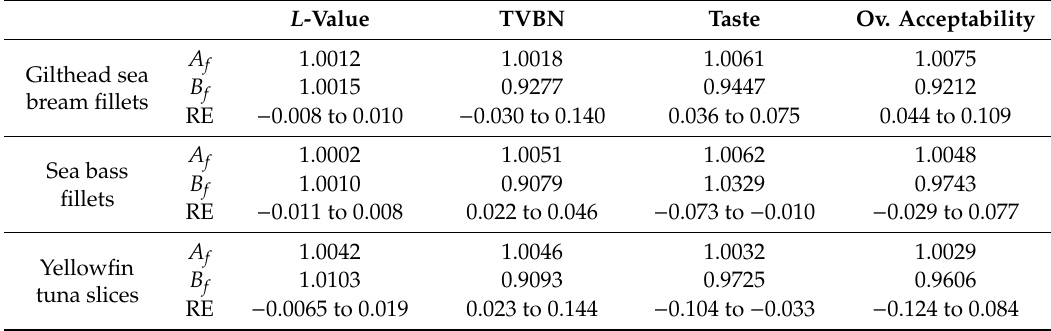
Table 3. Performance evaluation of the mathematical models for the quality parameters of frozen